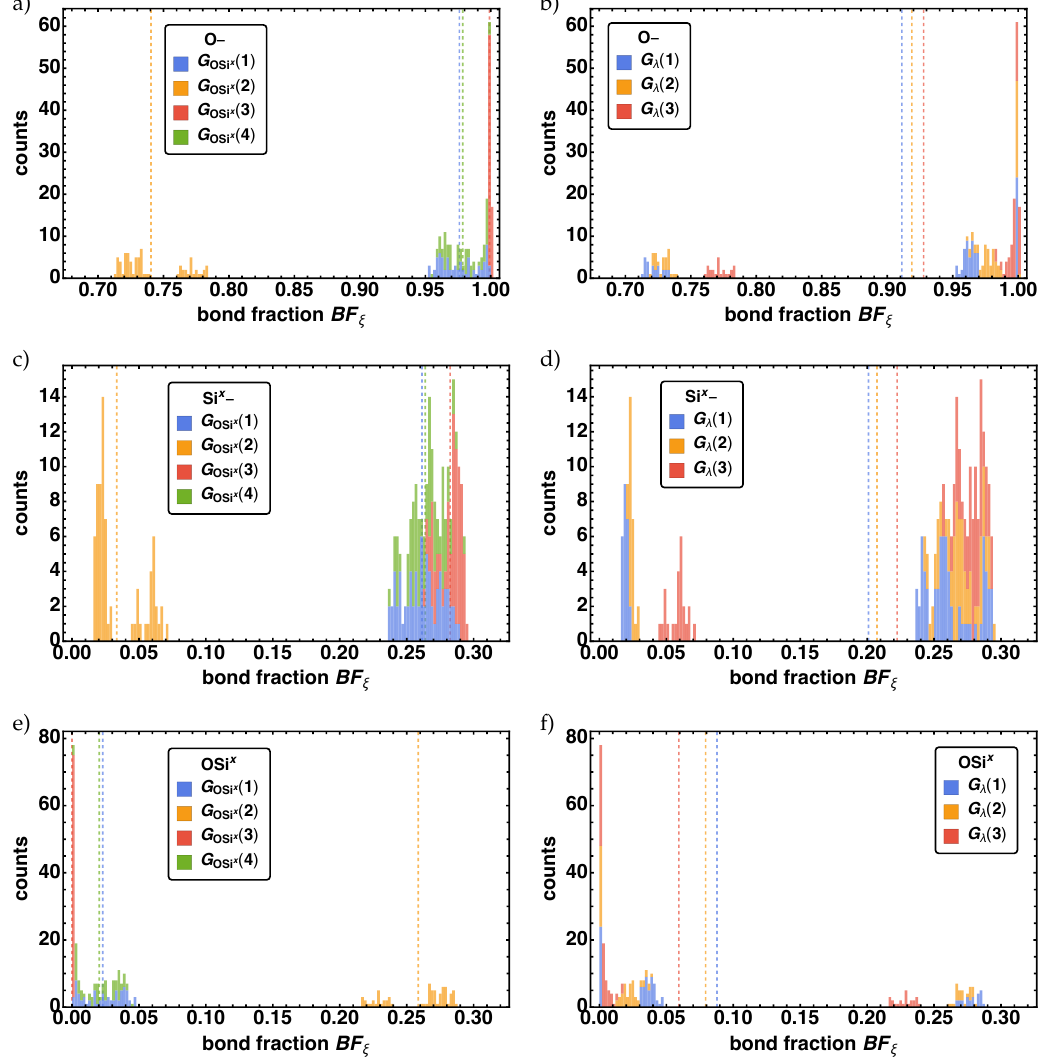
Figure 5. Distributions of the bond fractions BF ξ at t fin for the non-bonded reactions centers ξ = { O–, Si x – } in ( a – d ), and the bond vector type ξ = OSi x in ( e , f ) for the two parameter combinations G OSi x (left column) and G λ (right